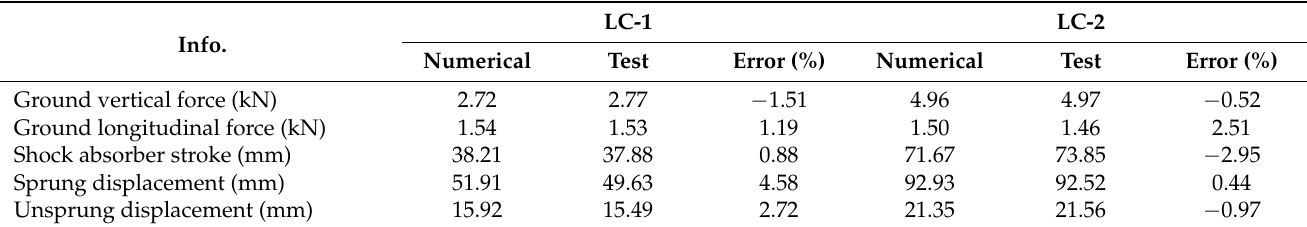
Table 3. Comparison of numerical results and test